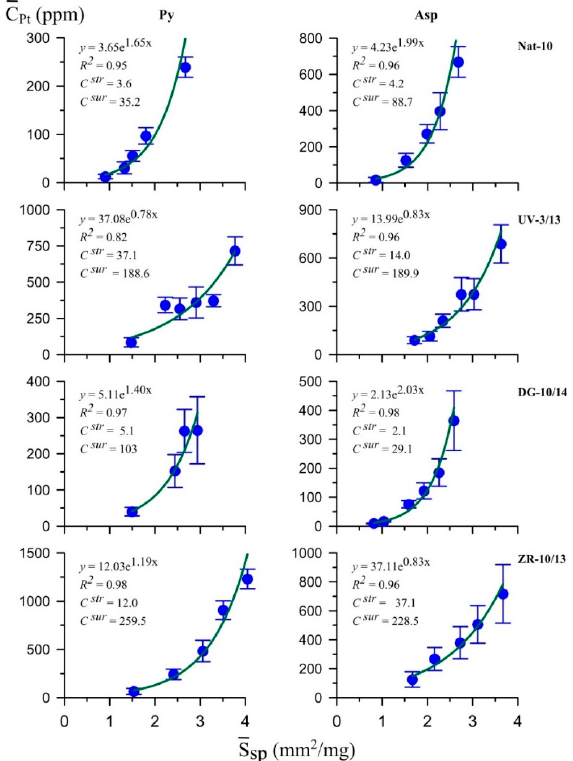
Figure 6. Dependence of the average concentration of evenly distributed Pd in pyrite and arsenopyrite on the specific surface area of an average crystal in size fraction. See Figure 5 for explanations. Minerals 2019 , 9 , x FOR PEER REVIEW